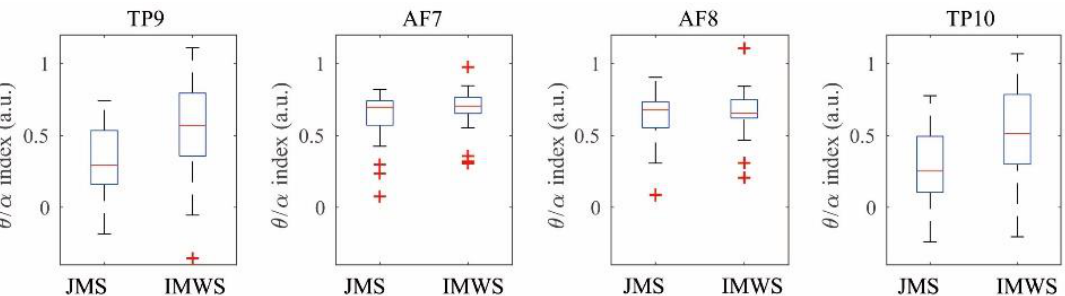
Figure 5. Between-session theta/alpha ratios paired t-test. JMS: Juingong meditation state, IMWS: IMW state, a.u.: arbitrary unit. The horizontal axis represents Juingong meditation state and IMW state. The vertical axis represents the theta/alpha ratio It can be seen that the theta/alpha ratio decreased in the JMS in the TP9 and TP10 channel. The theta/alpha ratio is a value obtained by calculating the theta power and alpha power in each channel, and then using them as the numerator and denominator, respectively. The theta/alpha ratio was also different in the AF channels, but the difference was smaller than that in the TP channels.